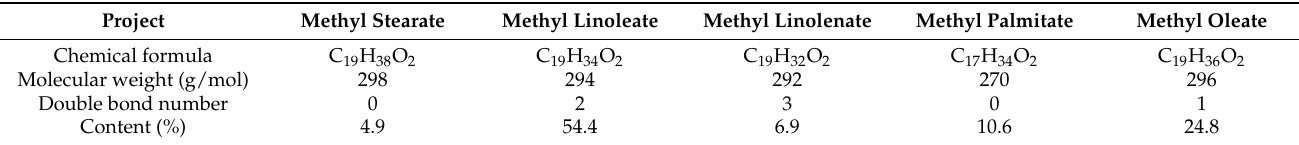
Table 3. The main composition and the properties of